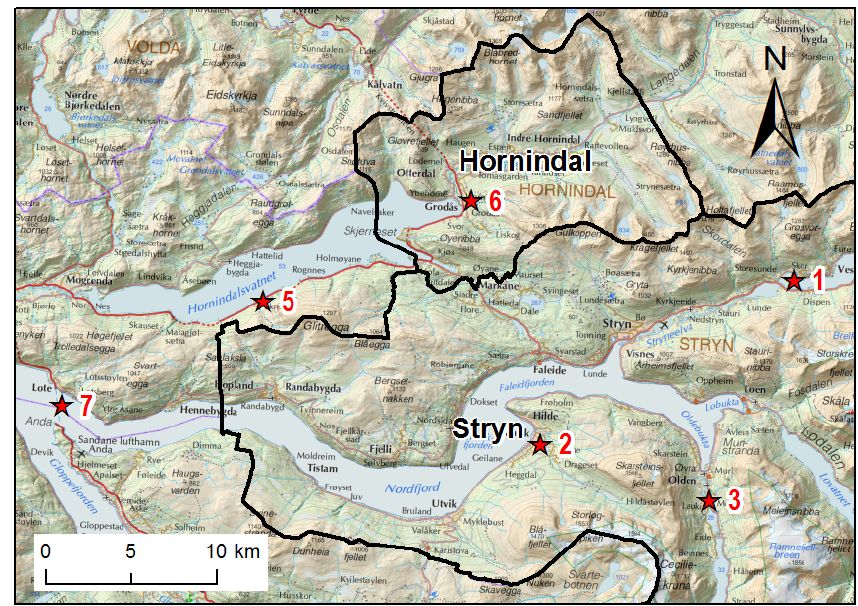
Figure 4. Overview of the locations of the site-specific scenarios. The location of each scenario is identified with a red star, referring to the scenario number in the list above. Star 1 shows the location of RV 15 in Stryn, but the actual scenario is located at a part of the road outside the map. Source: The Norwegian Mapping